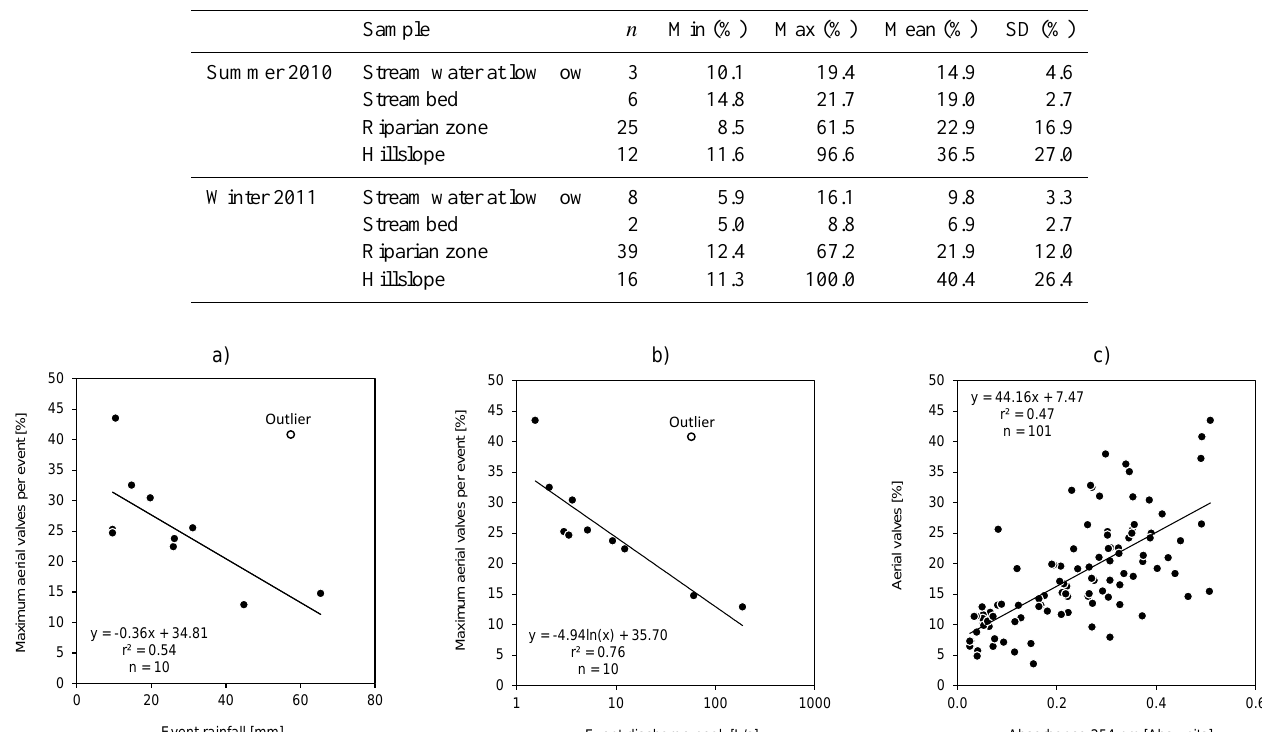
Table 3. Relative percentage of aerial valves quantified in distinct zones of the Weierbach catchment. Streambed samples refer to epilithon samples. Riparian zone samples include litter, bryophytes and vegetation. Hillslope samples include litter, bryophytes and surface soil sam- ples. Diatoms were absent on hillslopes covered by dry litter and samples were discarded.